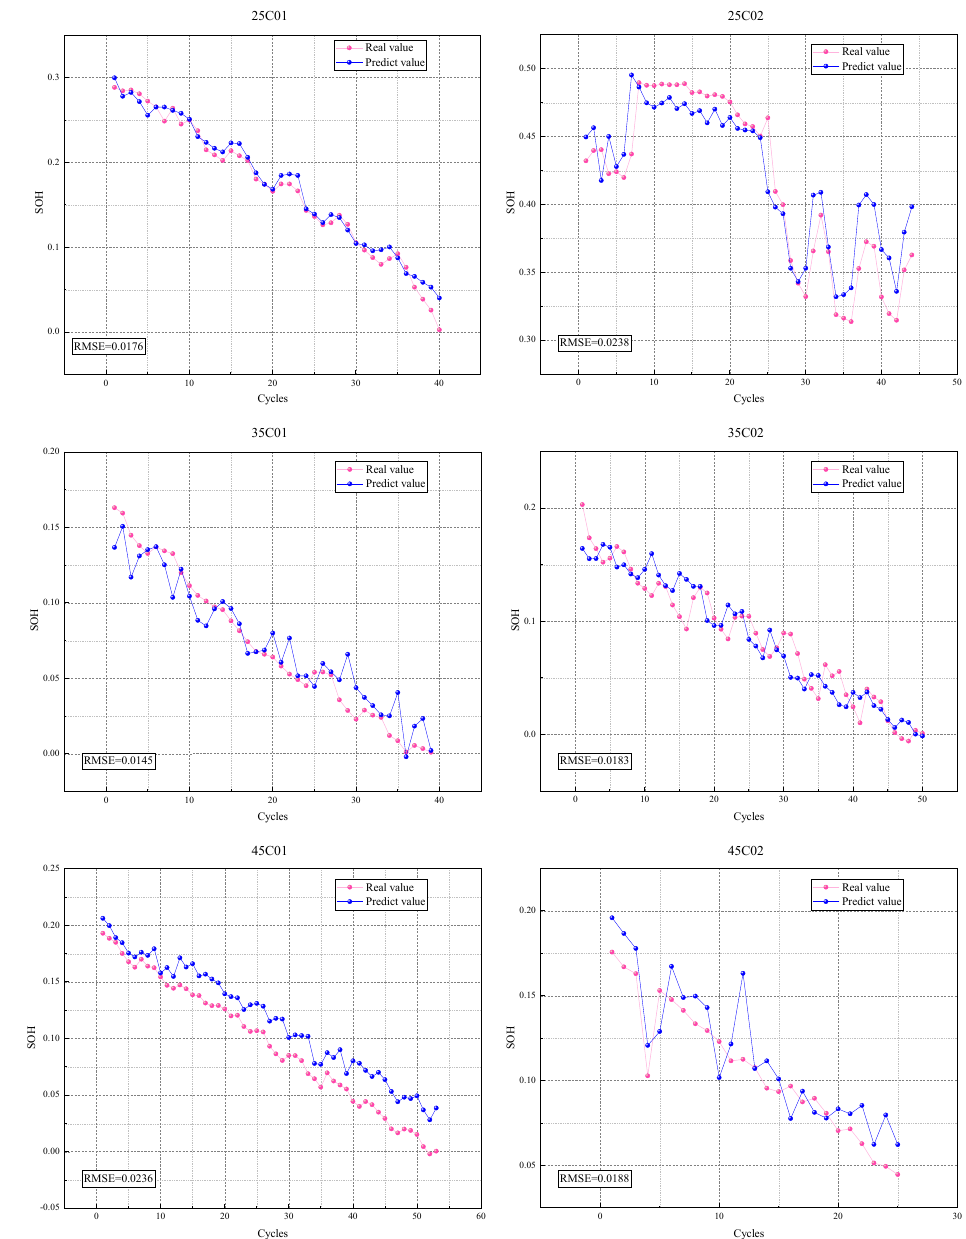
Figure 8. Prediction results of IPSO − CNN − BiLSTM for